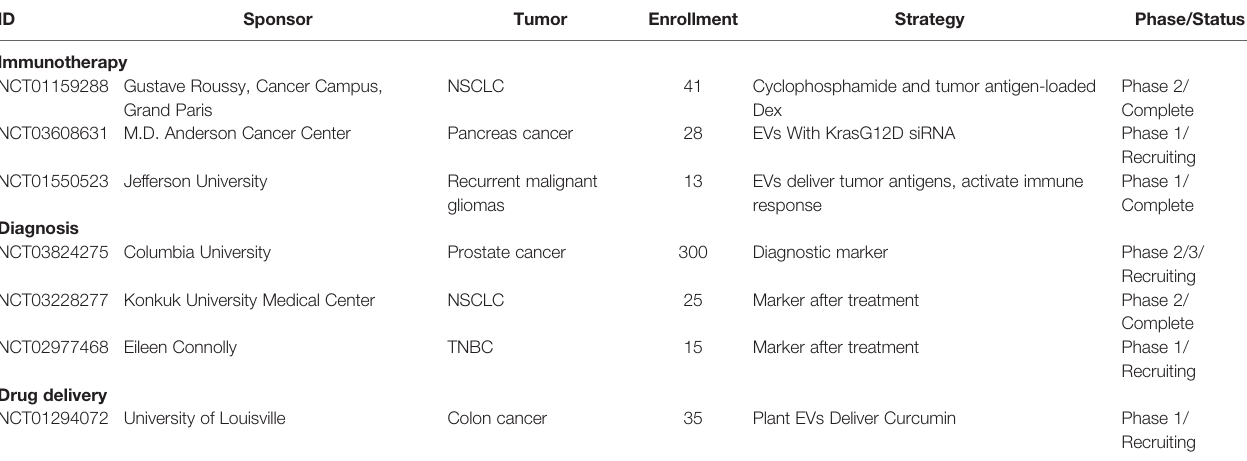
TABLE 1 | The part of ongoing clinical trials of cancer immunotherapy based on EV.